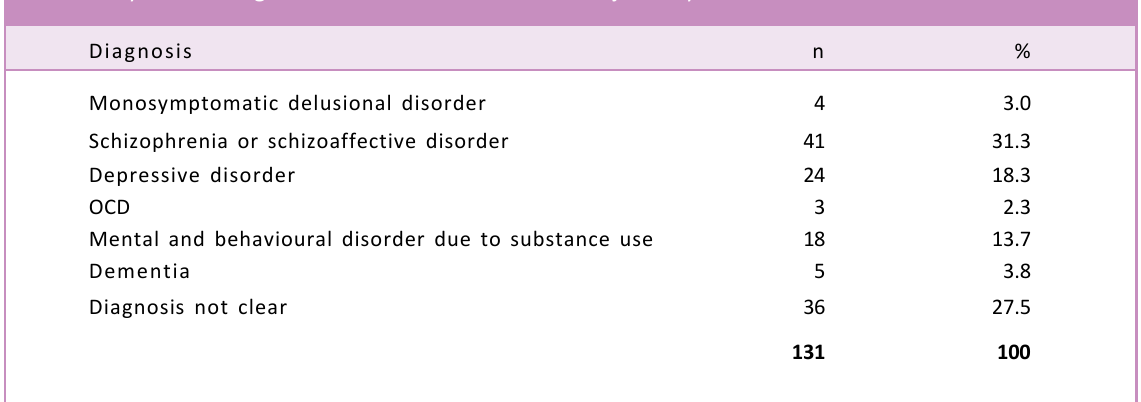
Table 1. Psychiatric diagnosis of individuals with morbid jealousy Diagnosis